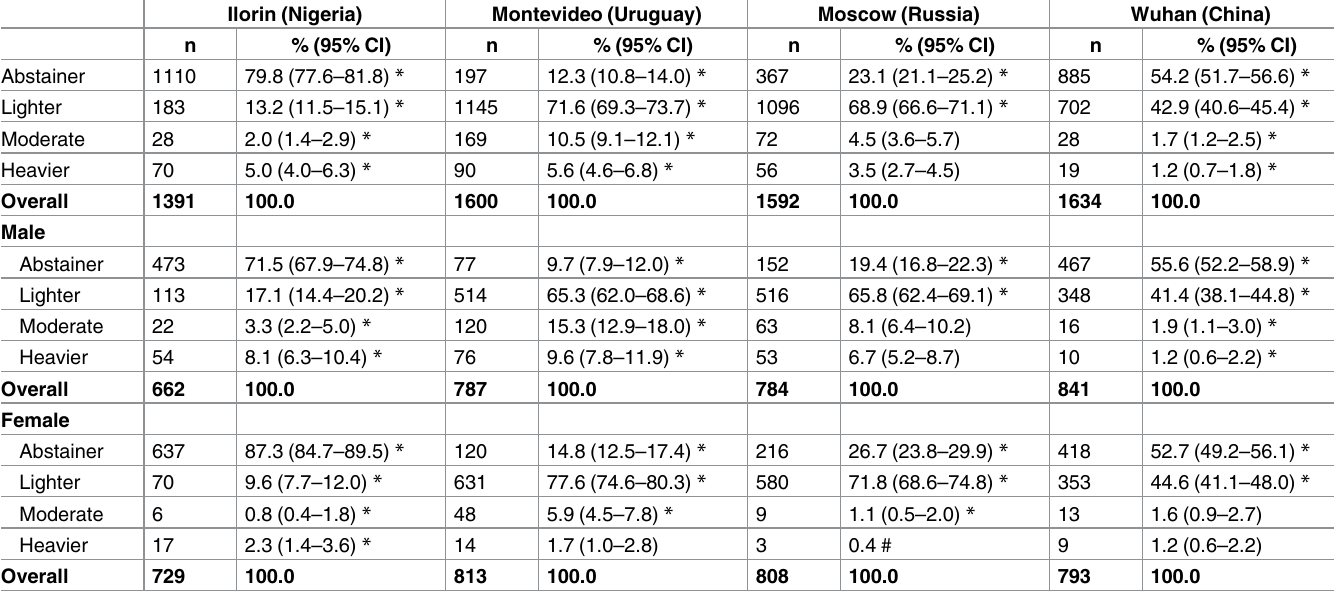
Table 4. QF- Four drinking status group (abstainers, light drinker, moderate drinker, and heavier drinker) by